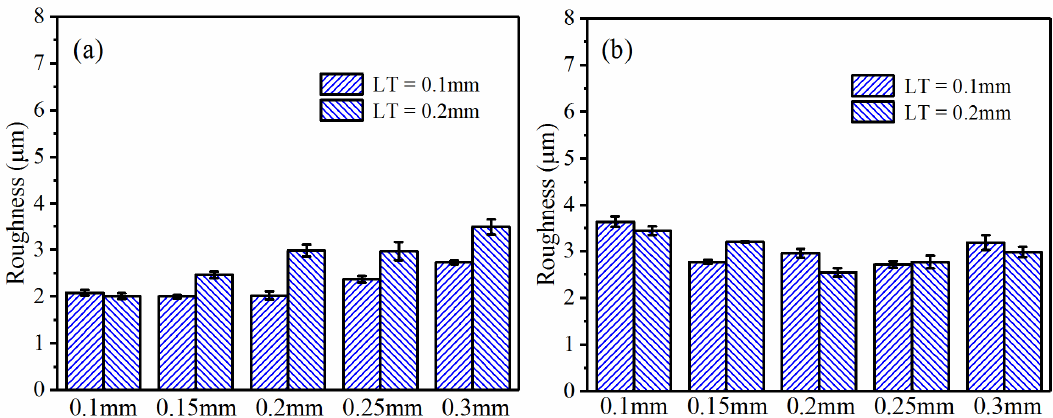
Figure 8. Roughness comparison subject to different LTs (RA = +45 ° / − 45 ° , SS = 3000 r/min, FRT = 0.04 mm): ( a ) PEEK; ( b ) CF/PEEK.